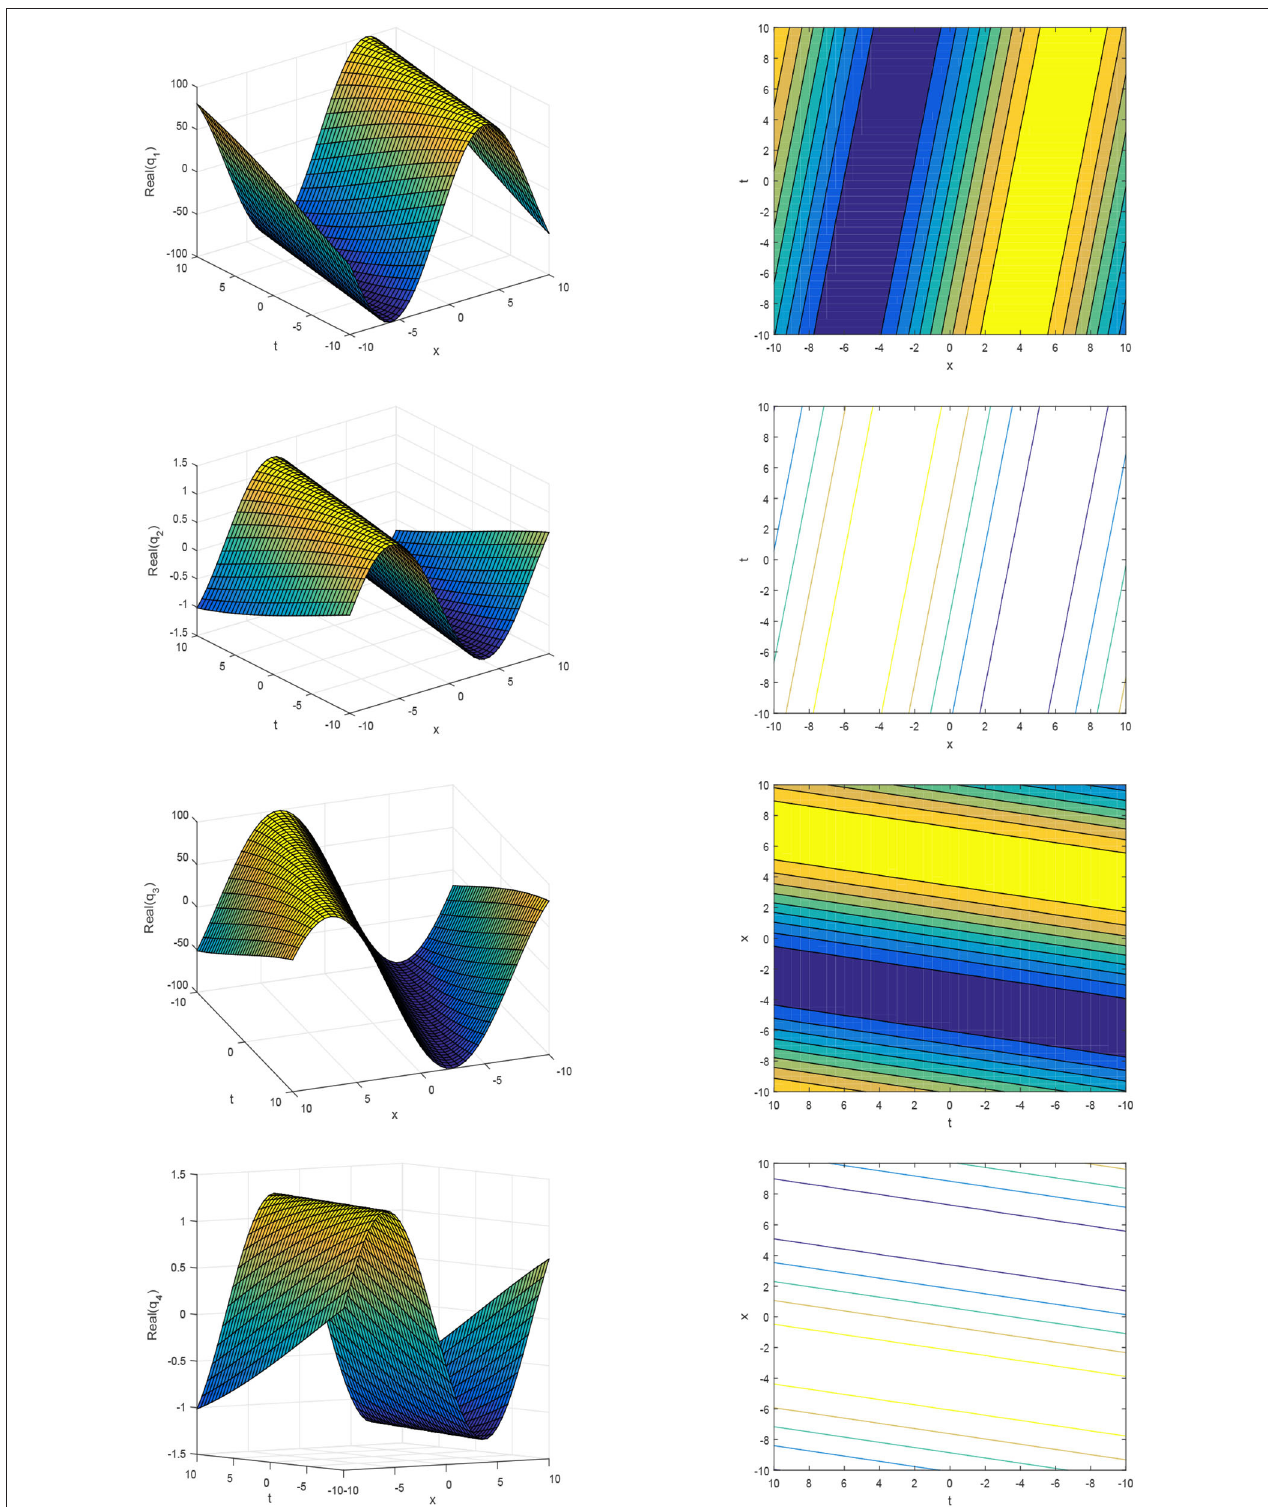
FIGURE 1 | The 3D plots and contour plots of the real part of solution q 1 ( x , t ) to q 4 ( x , t ) for different parameters.